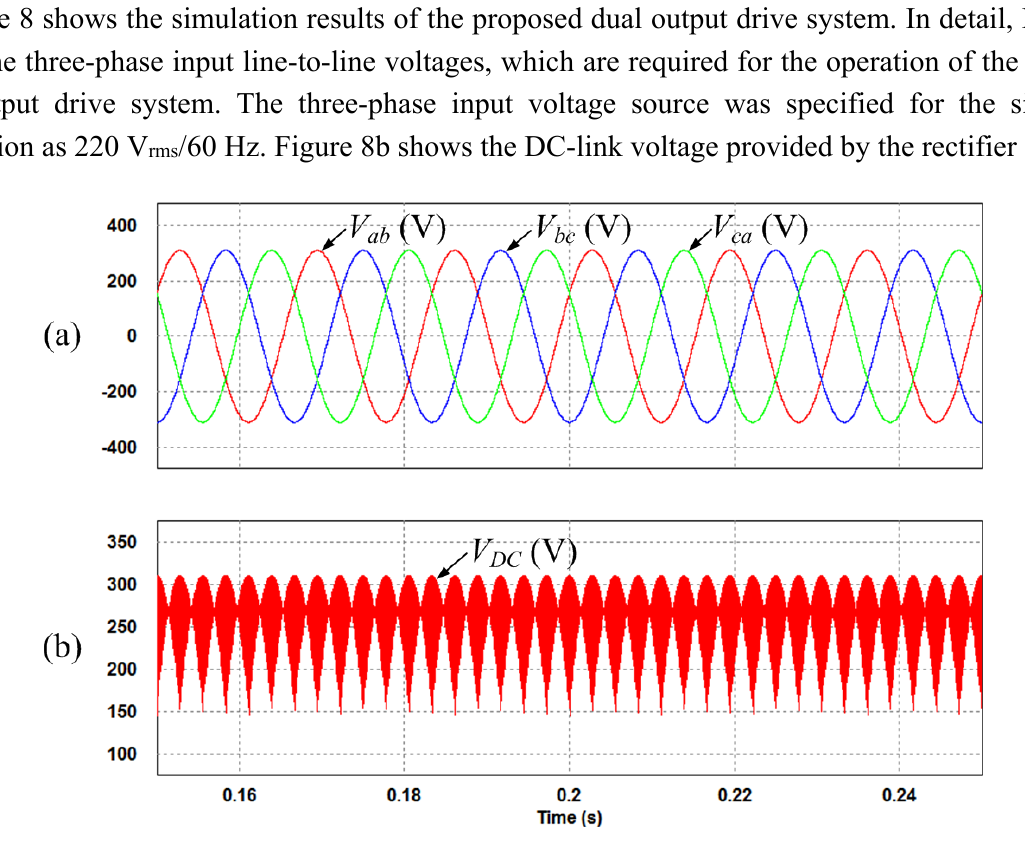
Figure 8. Simulation results of the proposed dual output drive system: ( a ) three-phase input line-to-line voltages; ( b ) DC-link